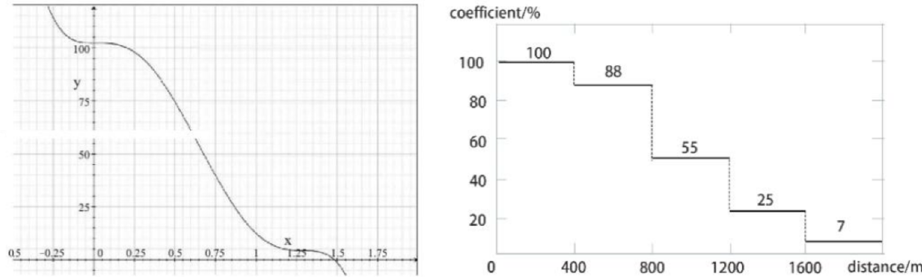
Figure 2. Distance attenuation curve and facility weight attenuation law.